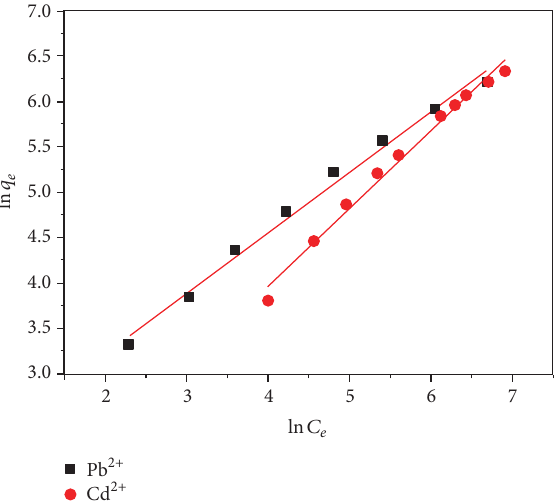
Figure 11: Freundlich isotherm curve fitting of Pb 2+ and Cd 2+ adsorption for cross-linked starch xanthate.